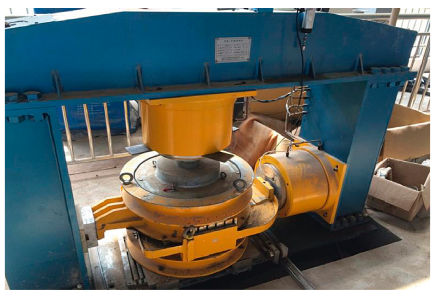
Figure 1: Direct shear testing